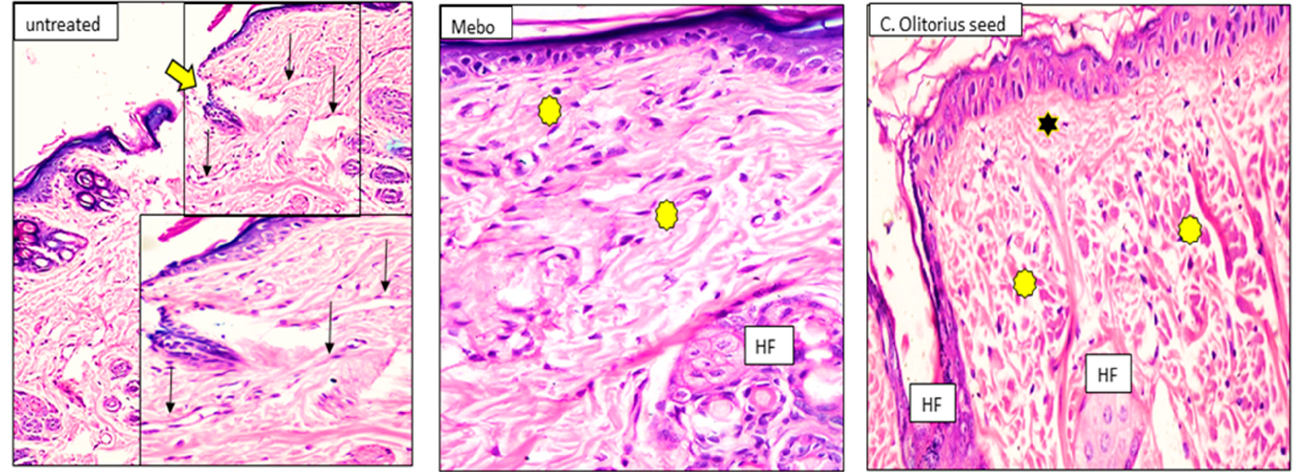
Figure 8. Wounded skin 14 days after incision; [untreated group] ( n = 8), showing the wide wound area (thick arrow) and the dermis underneath showing heavy inflammatory cellular infiltration and the blood vessels appear dilated and congested (arrows). [Mebo-treated group] ( n = 8), showing typical epidermis and the underlying dermis with coarse and compact collagen bundles arranged in different directions (asterisks). Newly formed hair follicles (HF). [ C. olitorius seed-treated group] ( n = 8), showing typical stratified squamous keratinized epithelium and the collagen in the papillary dermis appearing as fine interlacing bundles (stars), and in the reticular layer appearing as coarse and wavy bundles (asterisks). Notice the newly formed hair follicles (HF). (H & E stain × 200 and 400).